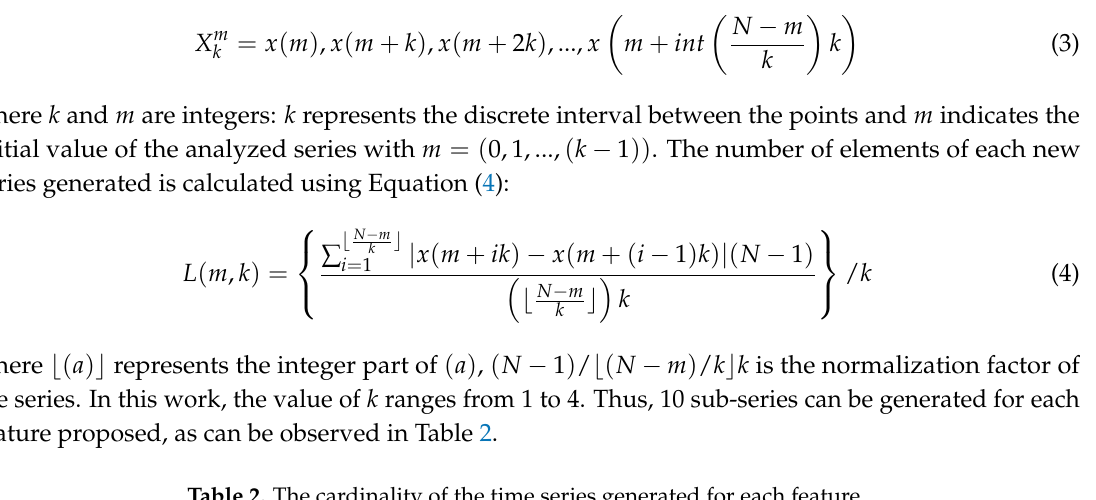
Table 2. The cardinality of the time series generated for each feature.